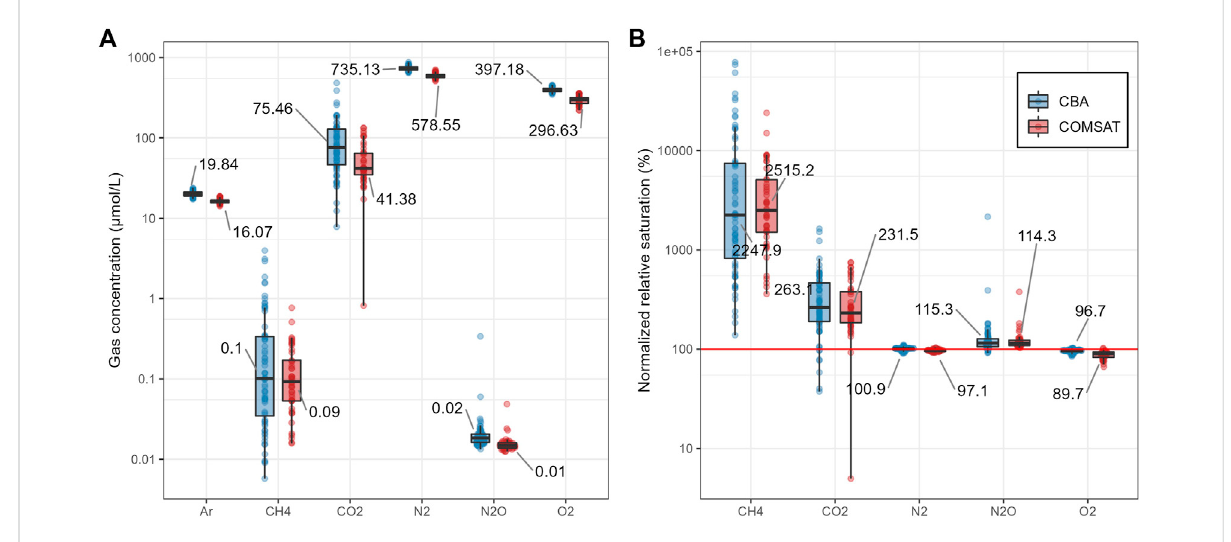
FIGURE 2 Surface water gas concentrations (A) and gas saturations (B) for CBA (blue) and COMSAT (red) datasets. Vertical axis are on a 10-base logarithmic scale. Data labels show median values for gas concentrations and